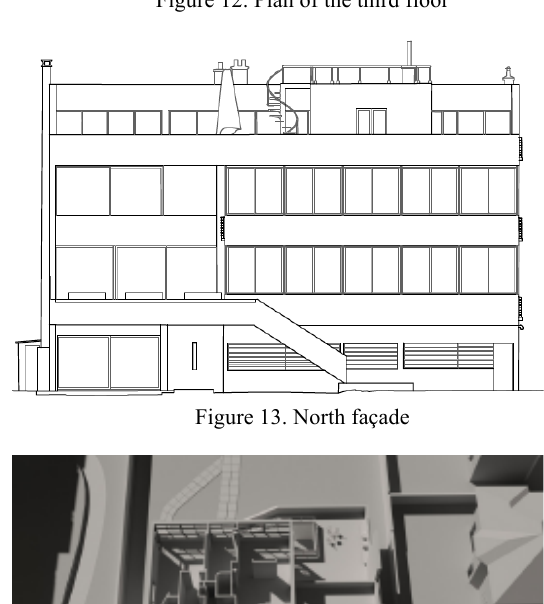
Figure 12. Plan of the third floor